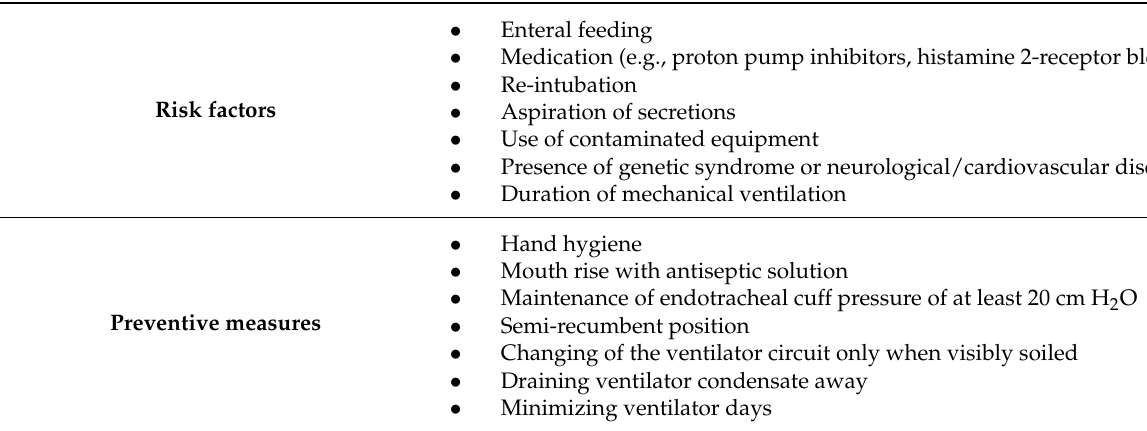
Table 1. Summary of risk factors and preventive measures identified in the